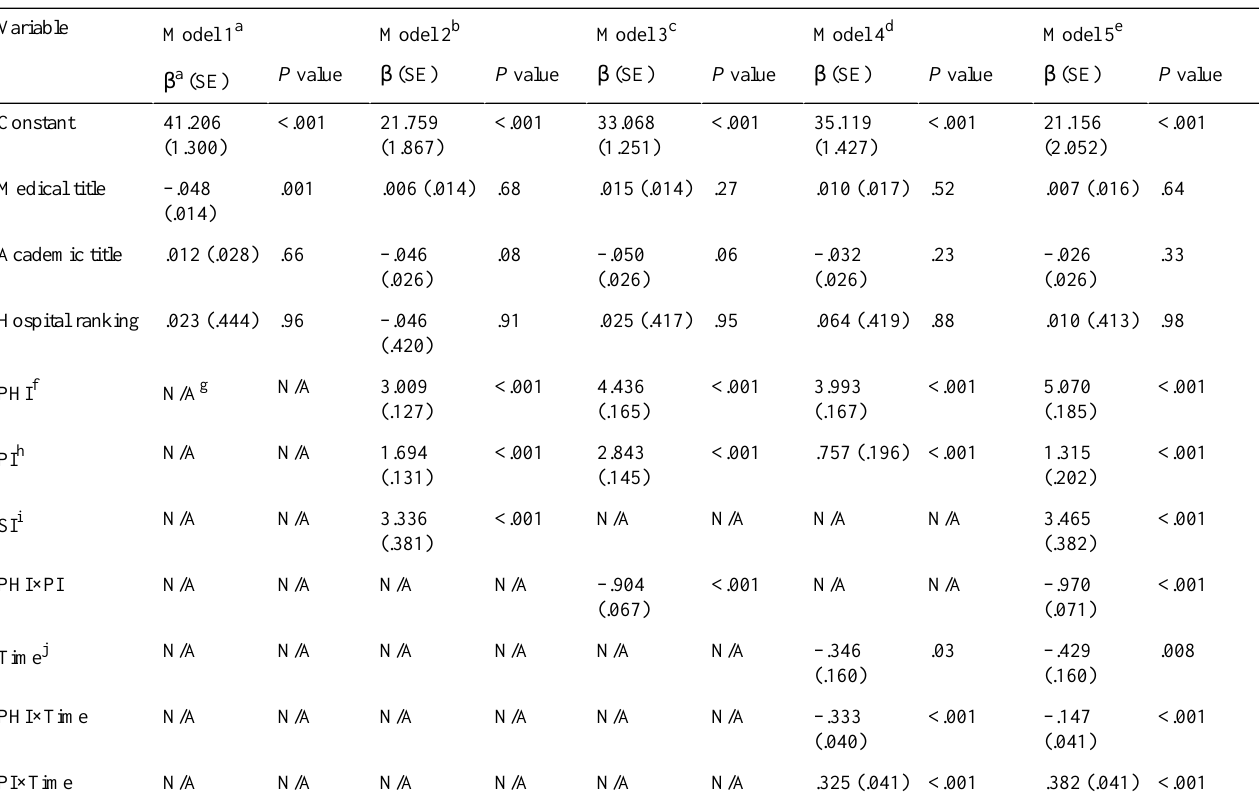
Table 4. Regression results (fixed-effects